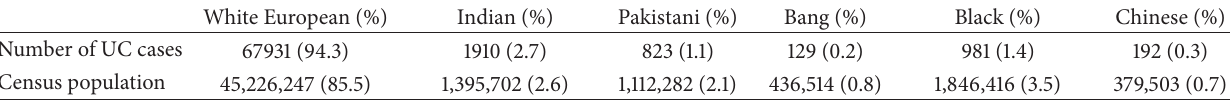
Table 2: Comparison of number of UC cases and census population by